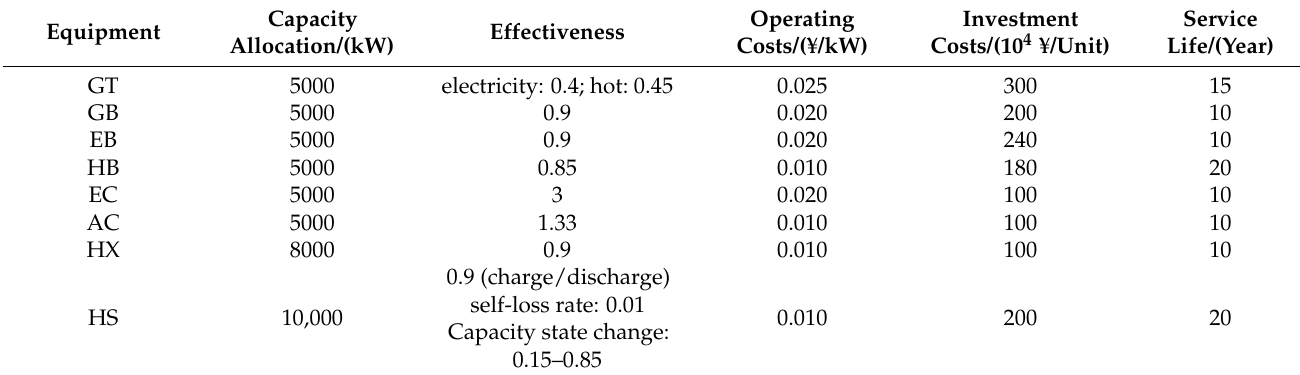
Table A1. Device parameters.